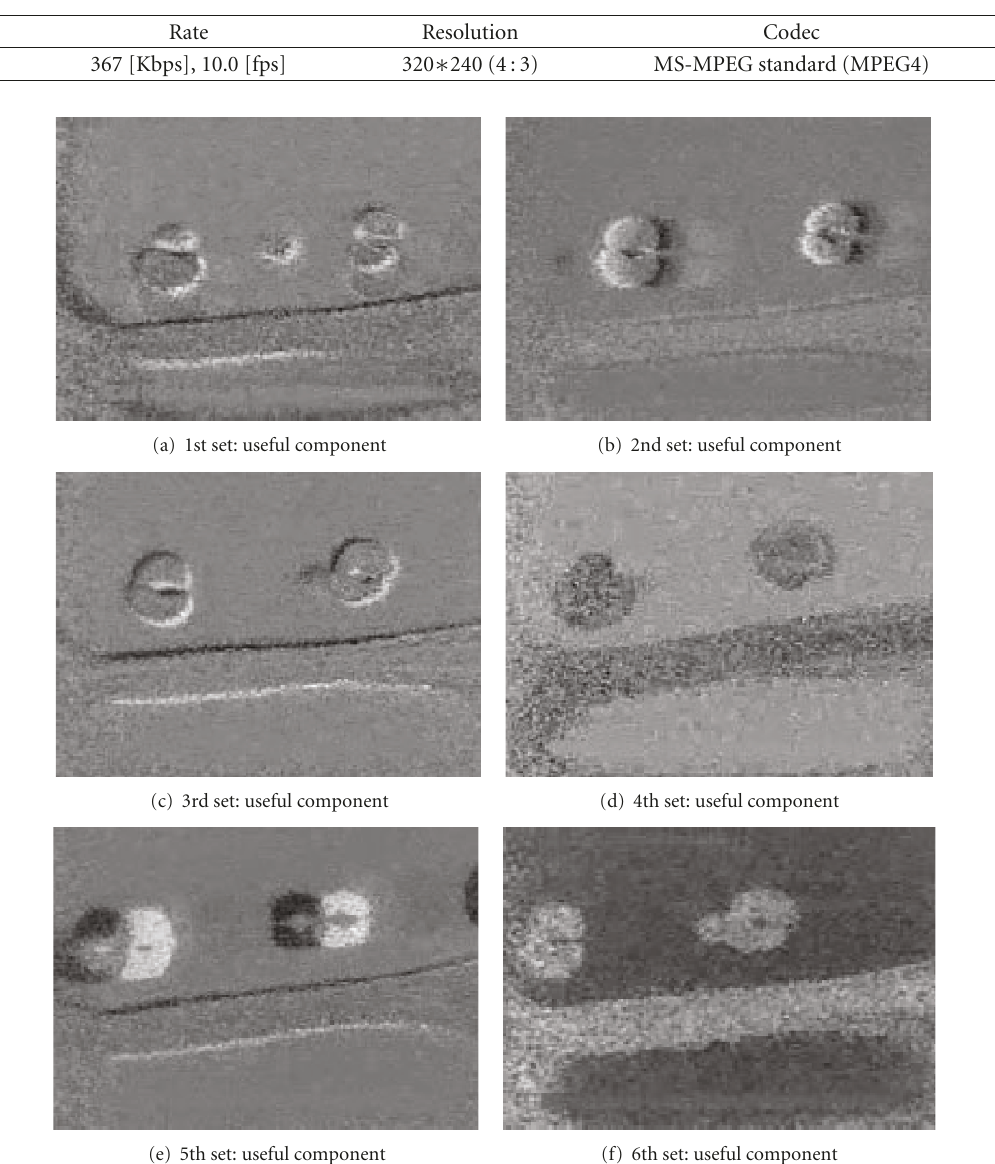
Figure 6: Independent components showing the informative signals, extracted from the in-study sets of magneto-optic images by the proposed